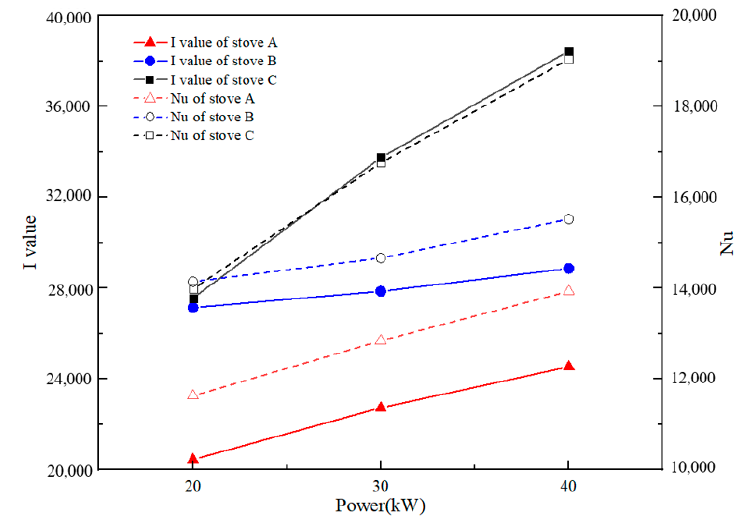
Figure 8. Nu number and I value of the three stoves at different powers.